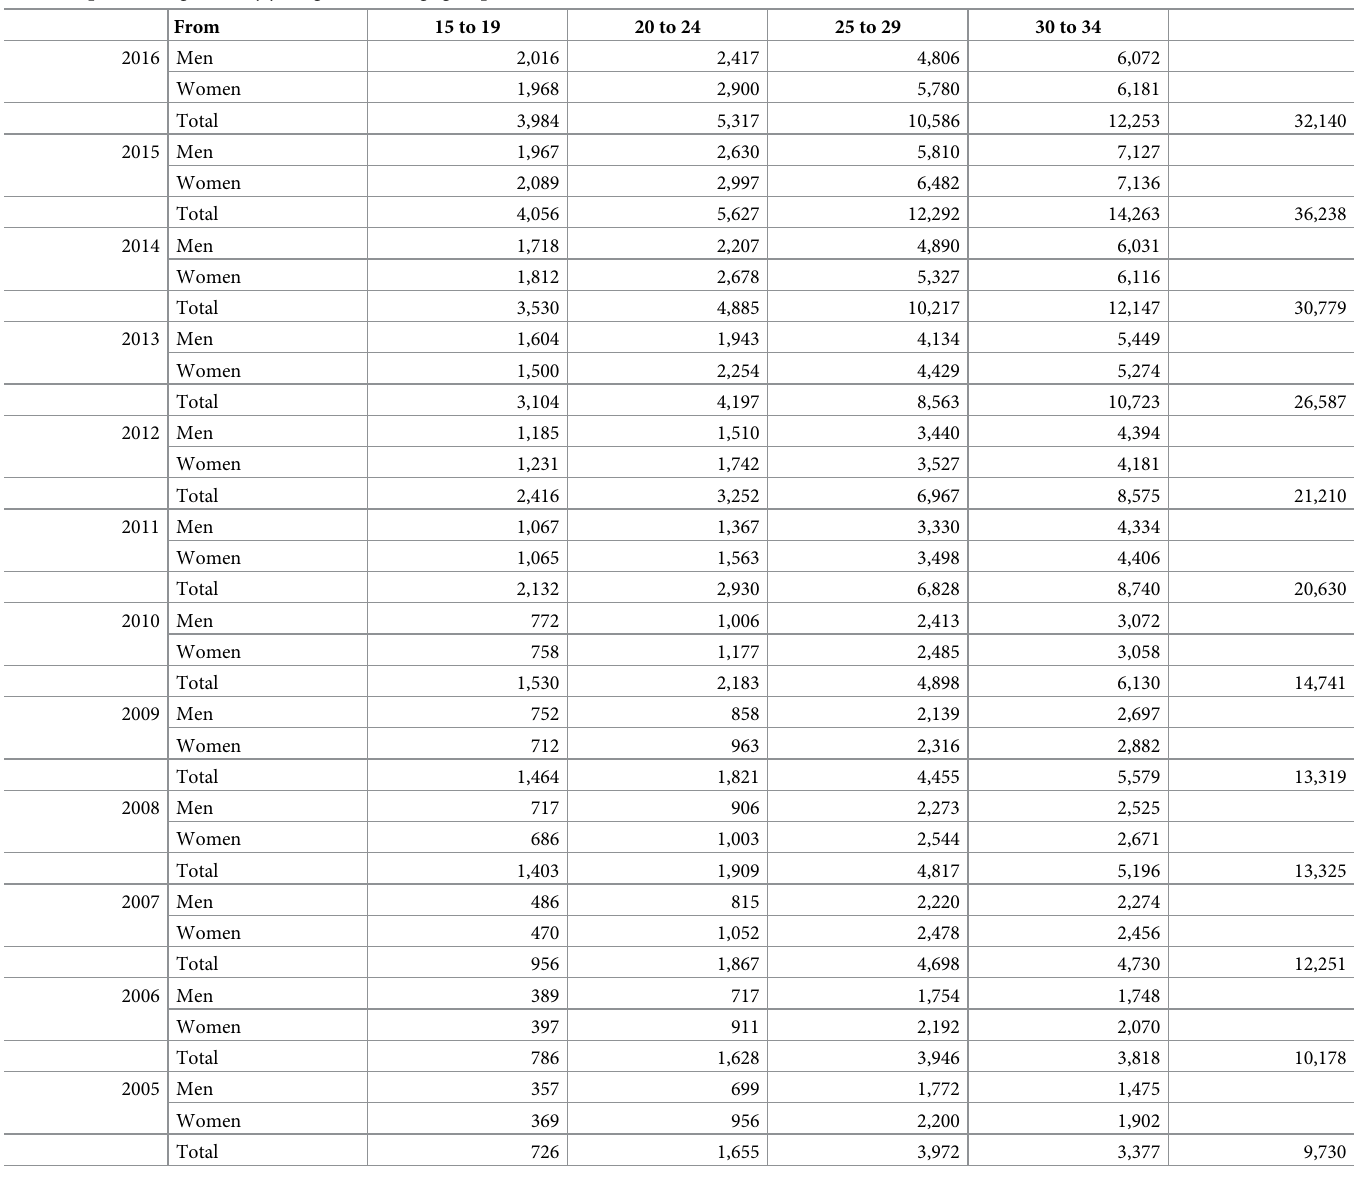
Table 1. Spanish emigration by year, gender and age group.